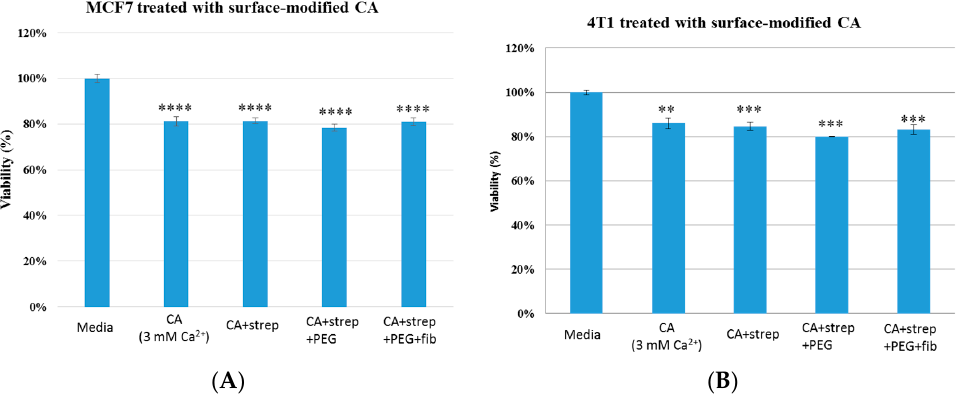
Figure 4. Cell viability of MCF7 ( A ) and 4T1 ( B ) cells after 48 h of treatment with CA and surface- modified CA particles. Surface modifications includes CA + streptavidin, CA + streptavidin + biotin–PEG and CA + streptavidin + biotin–PEG + fibronectin with untreated cells and CA particles alone considered as controls. CA: carbonate apatite; strep: streptavidin; fib: fibronectin.